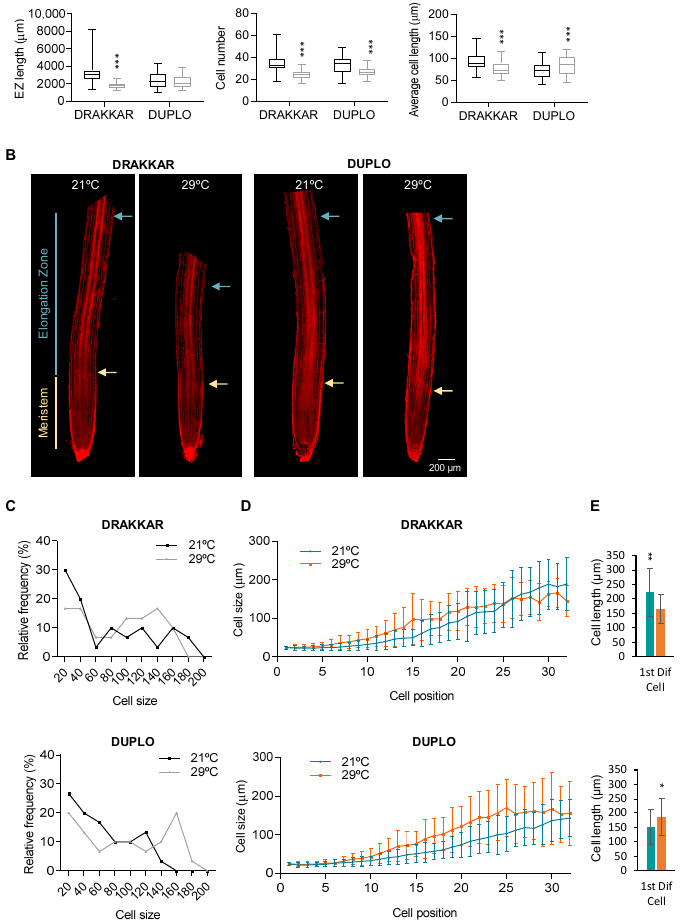
Figure 4. Warm temperatures increase cellular elongation in B. napus roots. ( A ) Elongation zone length, cell number, and average cell length of cells in the root EZ of Drakkar and Duplo varieties grown at 21 ◦ C and 29 ◦ C. Statistical t -test analysis, *** FDR < 0.01. ( B ) Confocal microscope images of mPS-PI-stained roots of 5-day-old seedlings of Drakkar and Duplo varieties grown at 21 ◦ C compared to 29 ◦ C. Yellow and blue arrows indicate the boundary between the root meristem and the EZ, and the EZ and the differentiation zone, respectively. Scale bars, 200 µ m. ( C ) Cell size frequency distribution of the first 30 cells in the root elongation zone of Drakkar and Duplo varieties grown at 21 ◦ C and 29 ◦ C. ( D ) Average cell length of EZ cells according to their relative position in the root of Drakkar and Duplo varieties grown at 21 ◦ C and 29 ◦ C. ( E ) Cell length of the first cell of the differentiation zone in Drakkar and Duplo roots grown at 21 ◦ C (green) and 29 ◦ C (orange) Statistical t -test analysis * p < 0.01, ** p < 0.001.